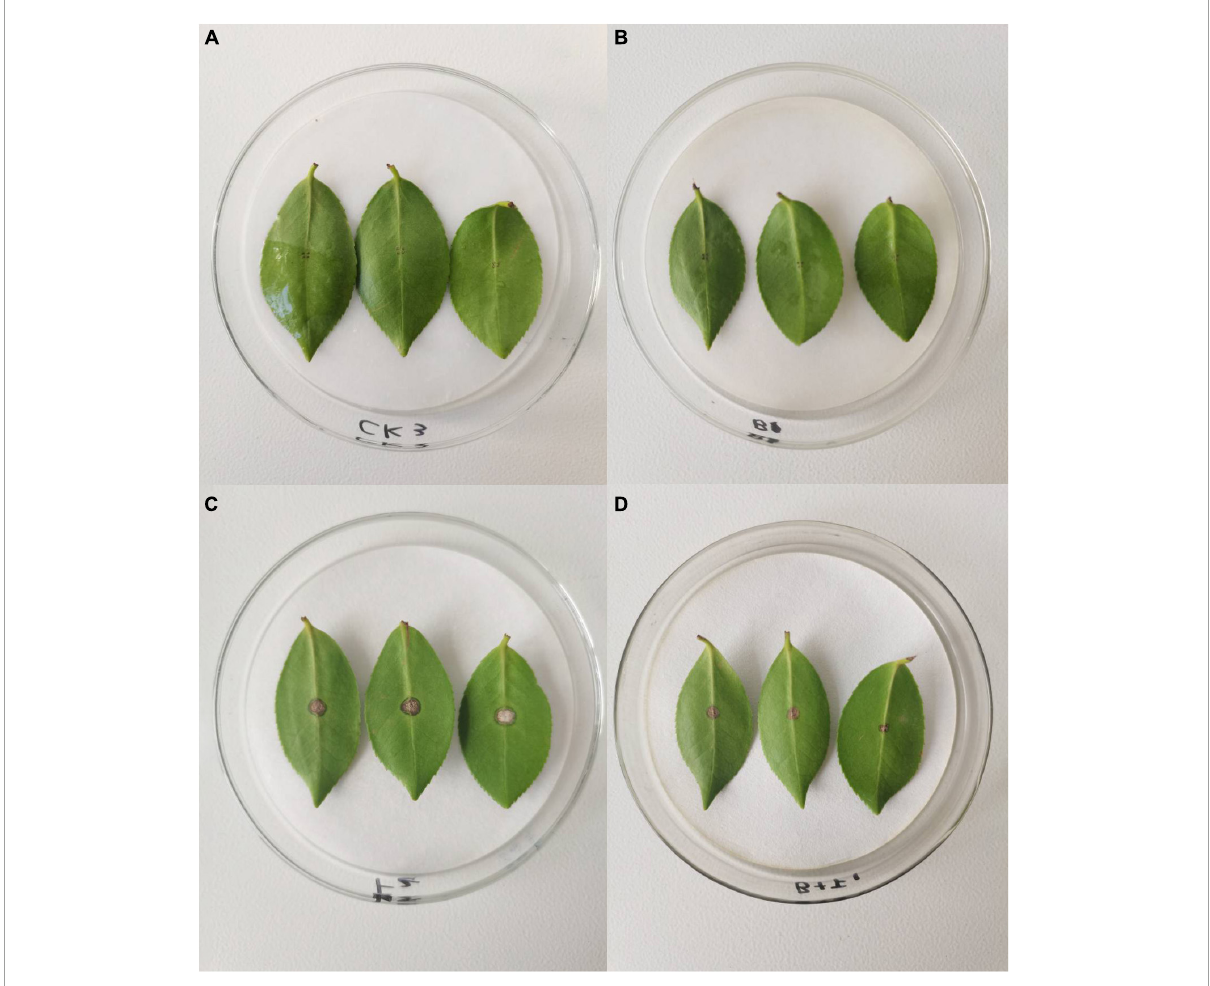
FIGURE3 The effect of Bacillus tequilensis YYC 155 on lesion development in detached leaves of C. oleifera caused by C. fructicola at 5 days after pathogen inoculation. Three independent replicates were used for different treatments and three detached leaves were used for each